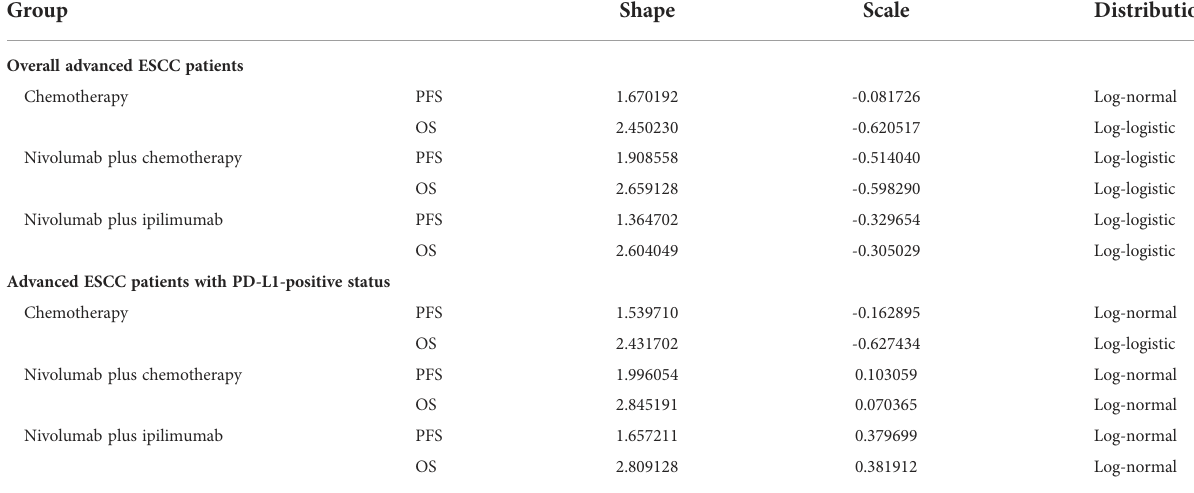
TABLE 1 Optimal distribution of progression-free and overall survival curves.